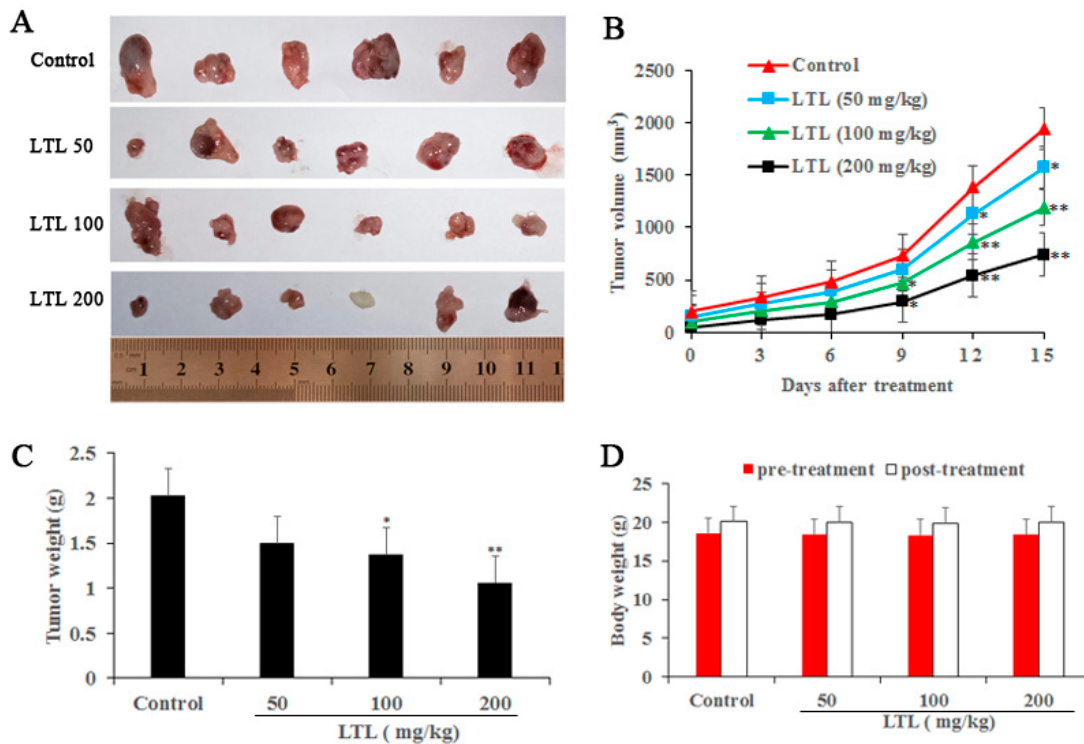
Figure 2. LTL inhibits tumor growth in the H460 xenografts mice model. Dissected tumors were photographed ( A ); and the tumor volume, tumor weight, and body weight from LTL-treated mice (0, 50, 100, and 200 mg/kg/day) were measured ( B – D ). The results are expressed as means ± SD of three independent experiments. * p < 0.05, ** p < 0.01, compared with the controls.